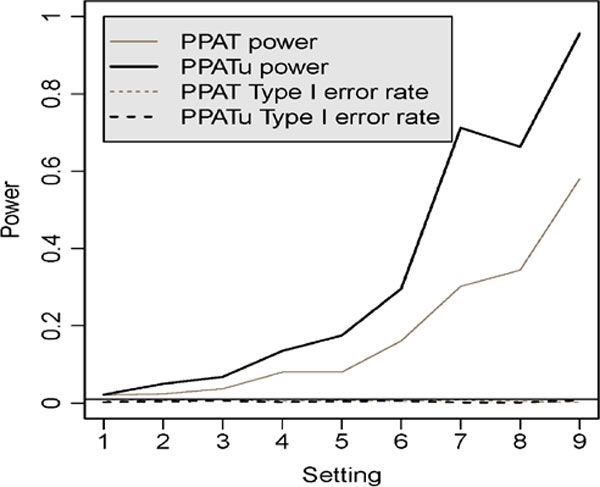
Type I error and power for PPATu and PPAT. The solid horizontal line marks the nominal significance level of 0.01. For power, the 9 settings are the 9 combinations of haplotype frequencies and imprinting models (as given in Table 1): 1 = (H1, I1), 2 = (H2, I1), 3 = (H3, I1), 4 = (H1, I2), 5 = (H2, I2), 6 = (H3, I2), 7 = (H1, I3), 8 = (H2, I3), and 9 = (H3, I3). For type I error, the 9 settings are the 9 combinations of haplotype frequencies and the no-imprinting models (as given in Table 1): 1 = (H1, N1), 2 = (H2, N1), 3 = (H3, N1), 4 = (H1, N2), 5 = (H2, N2), 6 = (H3, N2), 7 = (H1, N3), 8 = (H2, N3), and 9 = (H3, N3).